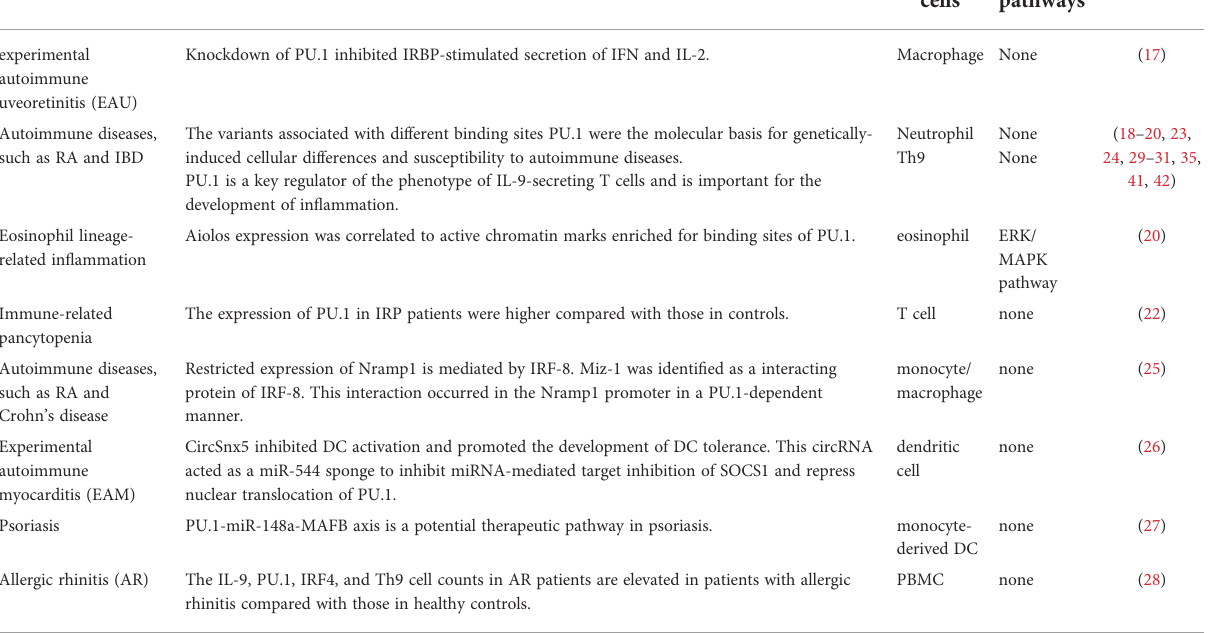
TABLE 1 The role of PU.1 in other autoimmune diseases.